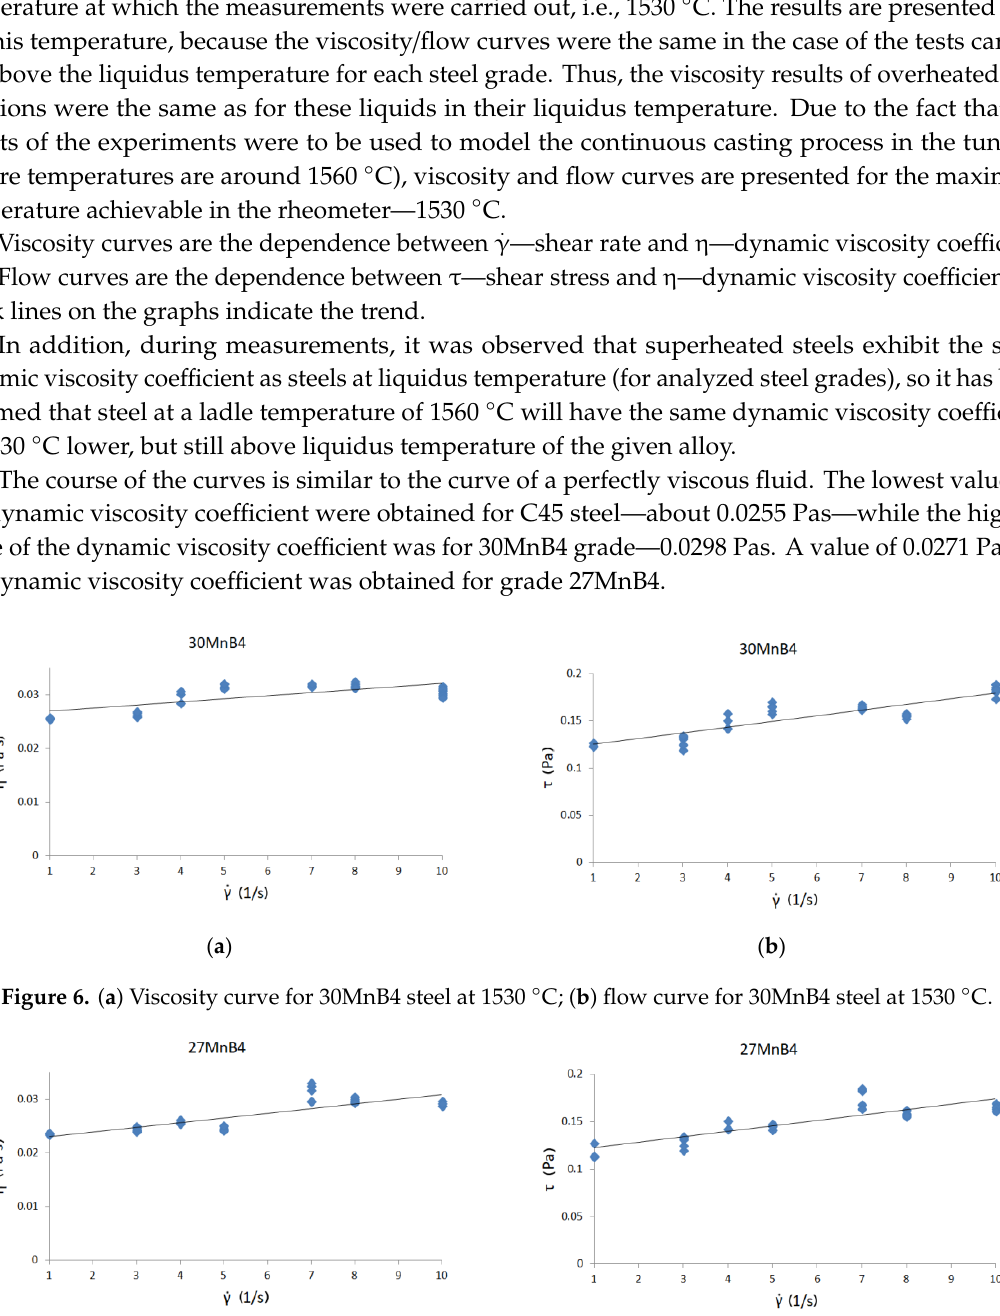
Figure 5. ( a ) Steel sample before measurement; ( b ) steel sample after measurement.